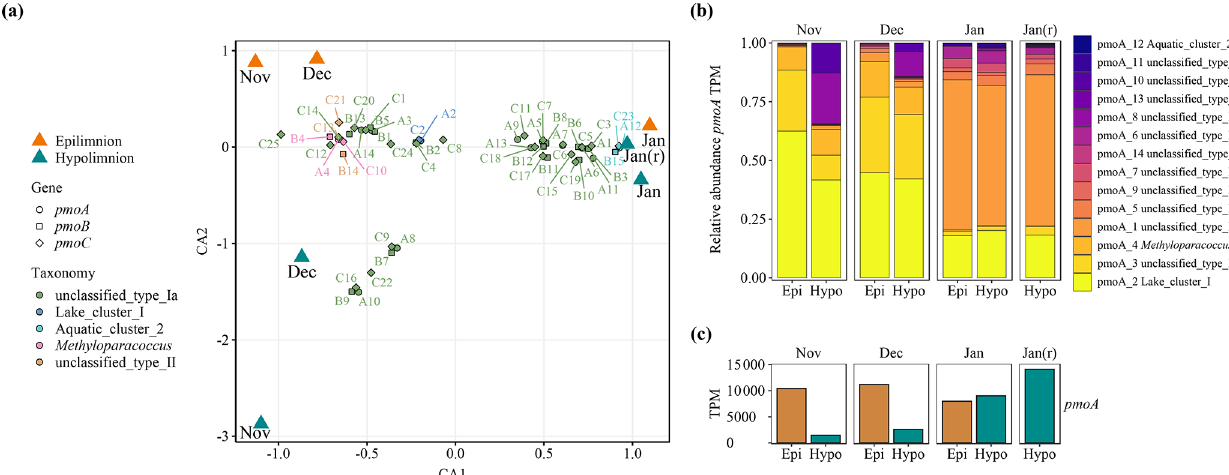
Figure 3. Transcribed gene variants encoding pMMO in November, December 2017 and January 2018 during overturn in Lake Rotsee. The January hypolimnion sample was extracted from two filters, and the replicate is labeled as Jan( r ). pmoCAB variants were assembled from metagenomic and metatranscriptomic samples and mapped at 99% identity. The samples originate from the same depths and dates as shown in Fig. 1. From October no metatranscriptomes are available. (a) Correspondence analysis (CA) of combined, square-root-transformed pmoCAB TPM (transcripts per million) data. Sample scores are shown as big colored triangles (orange represents the epilimnion, and cyan represents the hypolimnion). Sequence variant scores are shown as smaller symbols; circles represent pmoA , squares represent pmoB and diamonds represent pmoC . Identified variants of each gene are numbered and abbreviated as pmoA = A, pmoB = B and pmoC = C. Colors depict the taxonomic classification of the sequence variants based on a phylogenetic tree (Fig. S2). (b) The relative abundance of gene variants of pmoA based on transcripts per million (TPM). The corresponding figures for pmoB and pmoC variants are shown in Fig. S3. (c) pmoA is shown as the summed TPM of all variants for the epi- and hypolimnion (orange and cyan, respectively). “Epi” denotes the epilimnion, and “Hypo” denotes the hypolimnion. The figures for pmoB and pmoC are shown in Fig.